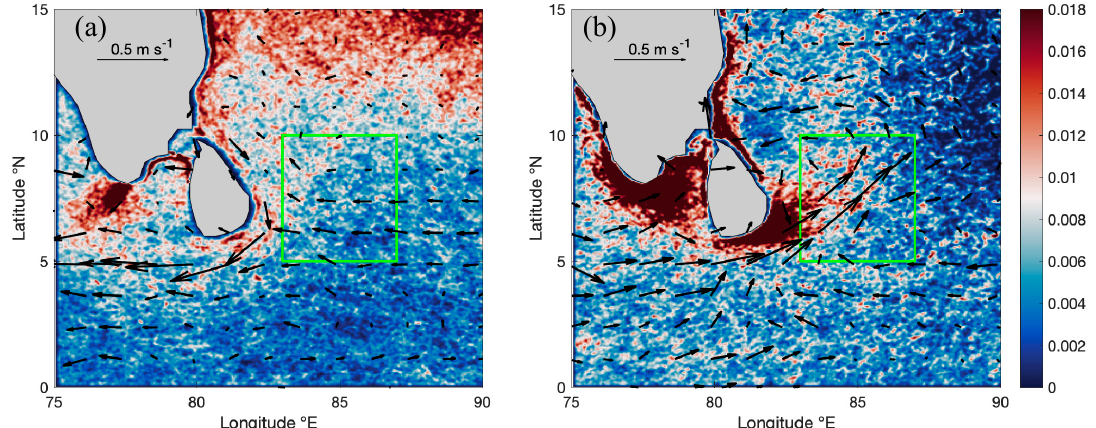
Figure 10. Frontal probability during ( a ) December–April and ( b ) June–September for the period of 2003–2020. Arrows are geostrophic currents of the specific season derived from the altimetry data. The green boxes denote the region of SLD.